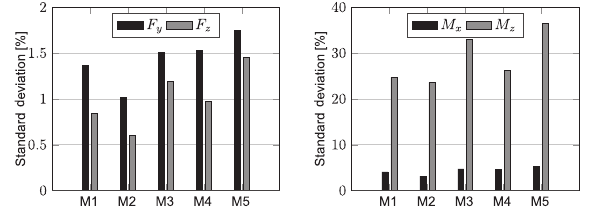
Figure 11. Standard deviation for five unfiltered measurements from a fictive mean value measurement: F y , F z , M x , M z .